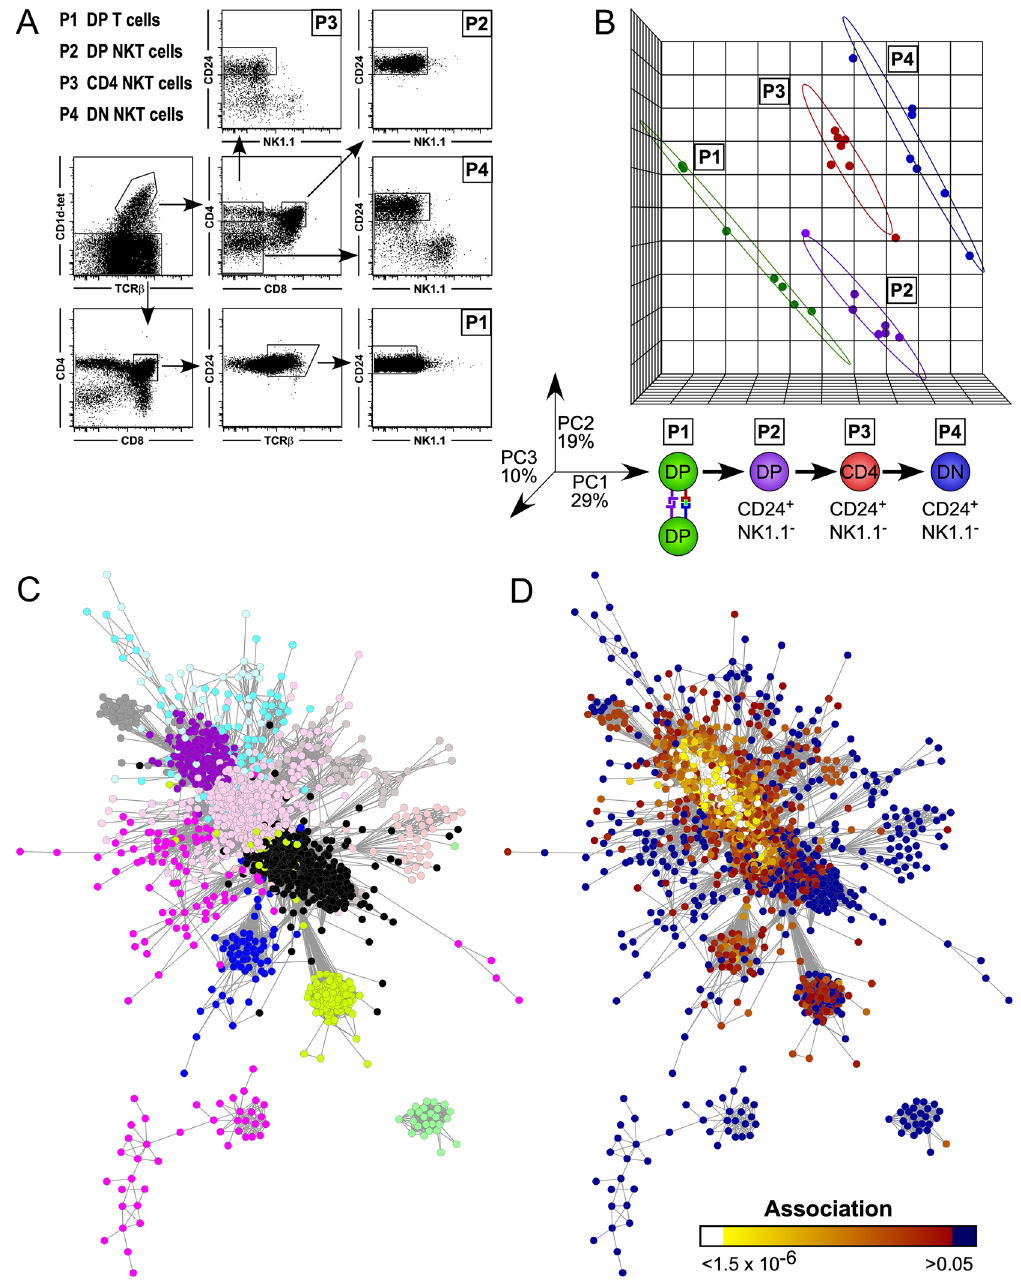
Figure 4. Microarray transcriptional comparison of FACS sorted cells. Microarray transcriptional comparison of FACS sorted thymic DP hi CD24 hi NK1.1 − CD1d-tet − TCRβ + (Population (P) 1 (P1)) cells, DP hi CD24 hi CD44 lo NK1.1 − CD1d-tet + TCRβ + (P2) cells, CD4 + CD8 − CD24 hi NK1.1 − CD1d-tet + TCRβ + (P3) cells and CD4 − CD8 − CD24 − NK1.1 + CD1d-tet + TCRβ + (P4) cells from individual NOD. Va14 tg /1 mice (n = 7). ( A ) Gating strategy for sorting of populations. ( B ) Principal component (PC) analysis of transcript expression. The three largest PC explain > 58% of variation; samples from each of the four cell types cluster together into groups, and the groups are distributed separately across PC1 (X axis), which explains > 29% of variation. A graphic illustrating the proposed NKT cell maturation pathway is provided for comparison. ( C ) Undirected, weighted transcriptional regulatory network generated from thymic NKT cell subsets P1–P4 (n = 7/population), consisting of 1,929 transcripts (nodes) and 10,626 pair-wise correlations (edges) across twelve co-regulated clusters (modules), named: Black (587 nodes), Cyan (71), GreenYellow (177), Grey (32), LightCyan (42), LightGreen (26), Magenta (127), MidnightBlue (68), Pink (525), Purple (188), Salmon (37) and Tan (49). ( D ) Heat map encoding of student’s t-test p values generated by pair-wise comparisons of transcript abundance across Transition 1 (P1 to P2) mapped onto the transcriptional regulatory network illustrated in panel C. (The WGCN depicted in ( C , D